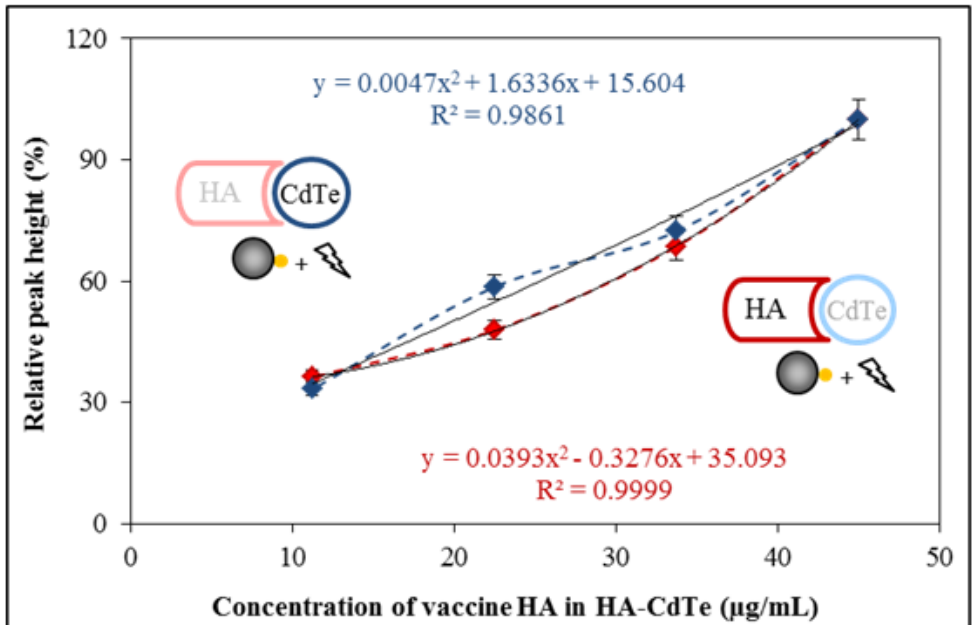
Figure 5. Detection of isolated HA-CdTe complex by electrochemical analysis. Dependence of relative peak height (related to the maximum value, Cd peak - blue colour, HA peak - red colour) on concentration of isolated HA-CdTe complex. Other experimental conditions see in Figure